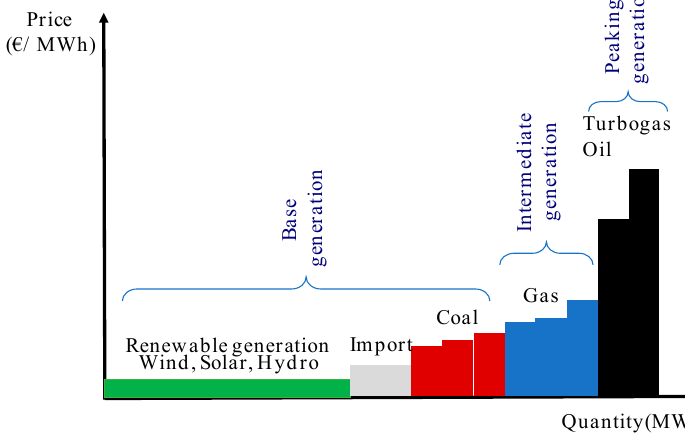
Figure 11. Merit order sequence for bidding in the IPEX market.